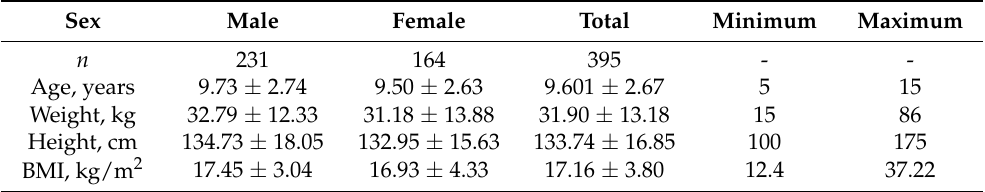
Table 1. Demographical data participated school children in rural areas.